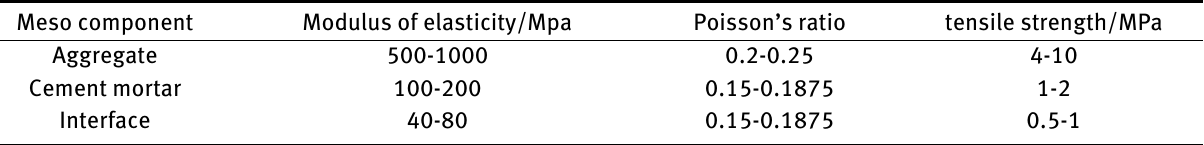
Table 1: Basic value of parameter sensitivity analysis